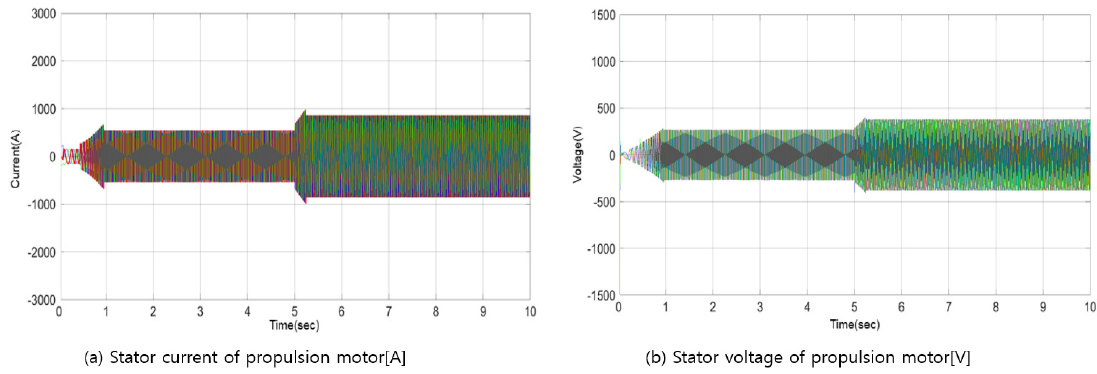
Figure 19. Simulation results of propulsion motor when load varies as 10 → 20[%].